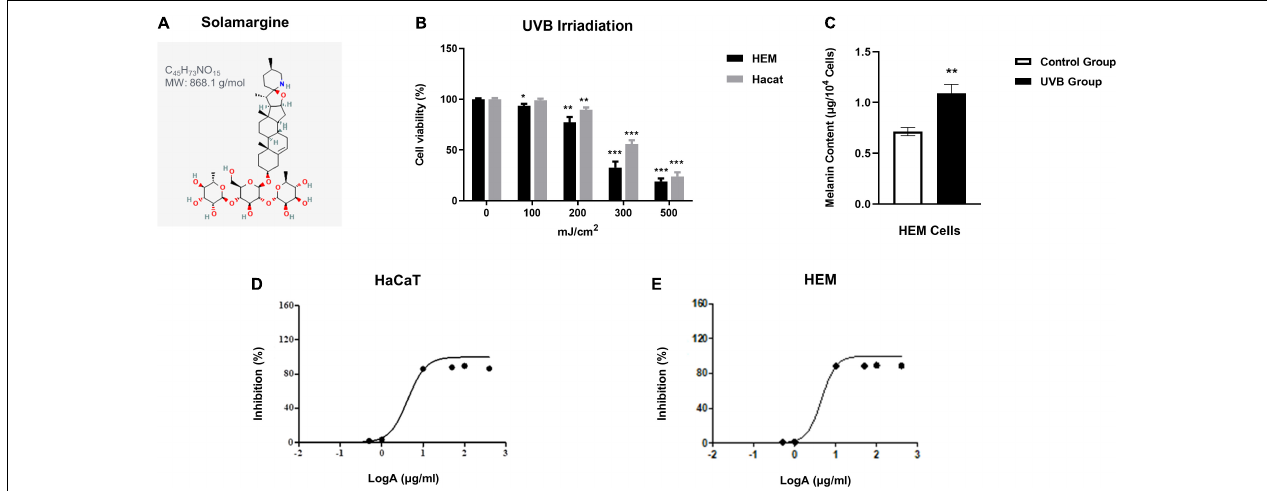
FIGURE 1 | Cell viability and melanin content of HaCaT and HEM cells after NB-UVB irradiation. The inhibition rate of HaCaT cells and HEM cells of different concentrations of SM. (A) The chemical structure of SM modified from https://pubchem.ncbi.nlm.nih.gov/compound/Solamargine. (B) Cell viability of HaCaT cells and HEM cells was detected by CCK-8 24 h after irradiation of NB-UVB with different fluences (100, 200, 300, and 500 mJ/cm 2 ). Cell viability is presented as a eprcentage of control. (C) Melanin content of HEM cells after irradiation of NB-UVB with 250 mJ/cm 2 Melanin content is percentage as a percentage of control. (D,E) The IC50 value for HaCaT cells was 4.252 µ g/ml and for HEM cells was 4.472 µ g/ml. * P < 0.05, ** P < 0.01, and *** P < 0.001.